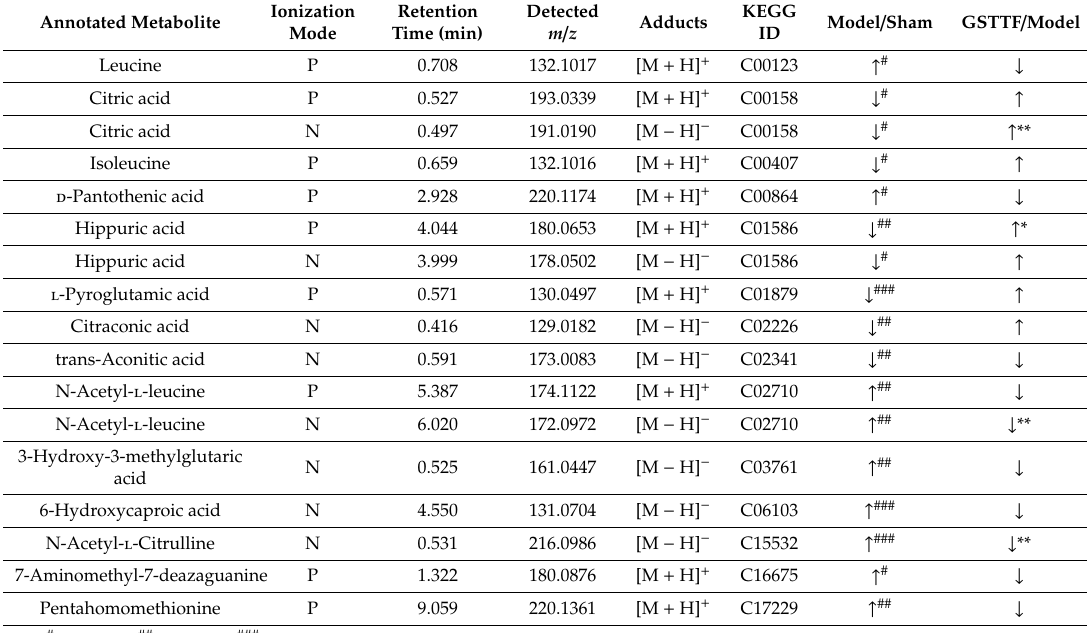
Table 1. Annotated endogenous metabolites and their change trends in urine.